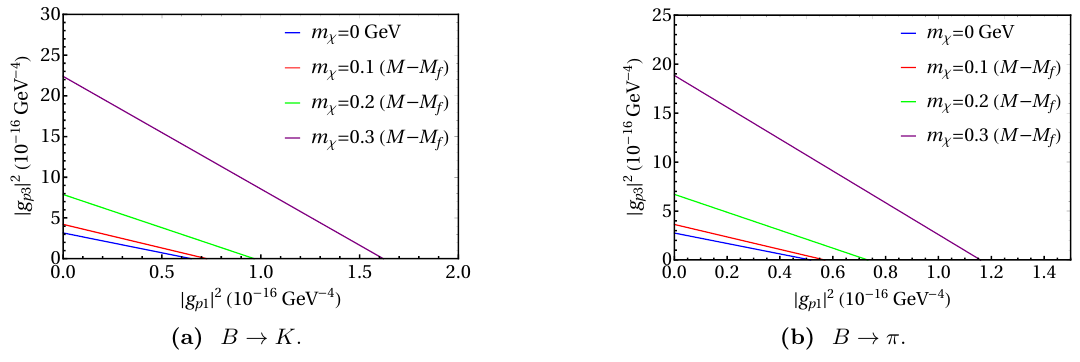
Figure 5. The allowed region of